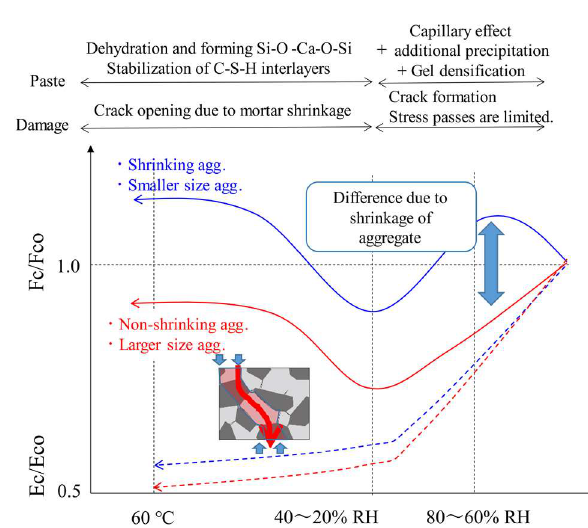
Figure 7. Schematic illustration of compressive strength change of concrete due to